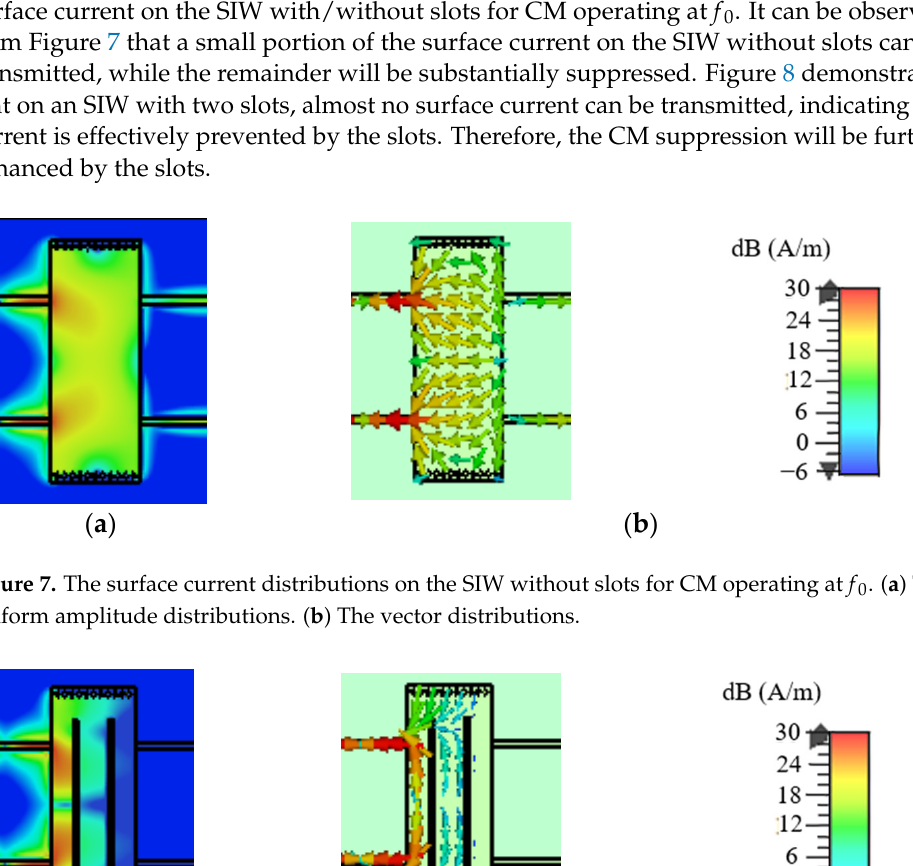
Figure 6. The simulated bandwidth for DM phase shift with ±5% phase deviation of the proposed balanced SIW phase shifter with different Δ d s , Δ w s , and Δ l s . ( a ) With different Δ d s . ( b ) With different Δ w s . ( c ) With different Δ l s .